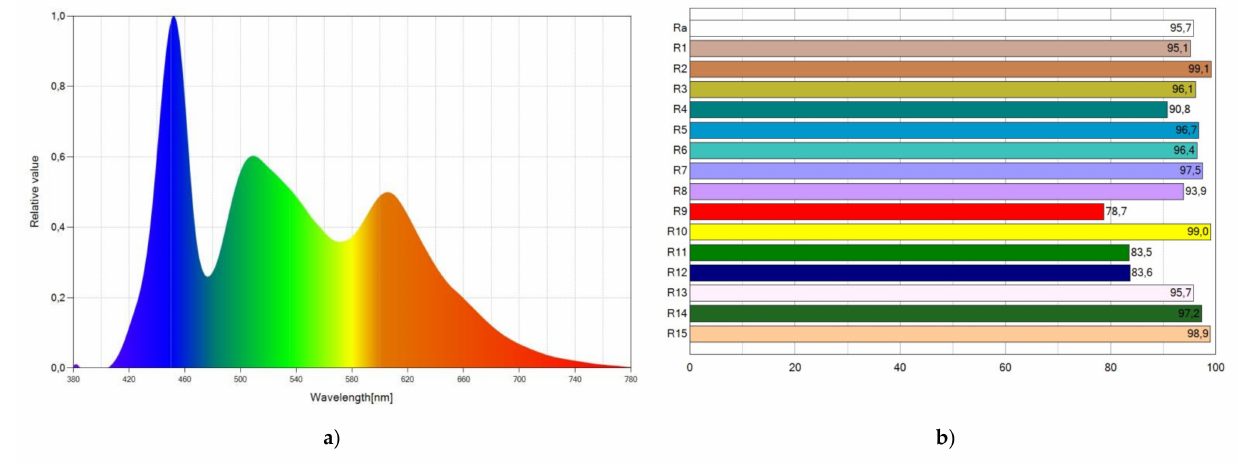
Figure 8. Spectral power distribution (SPD) chart ( a ) and CRI points ( b ) of WLED-11-I.